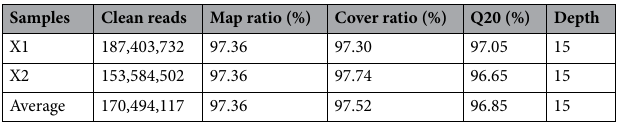
Table 1. Detail information of cucumber hybrid variety Lvmei No.1 parents, X1 and X2.